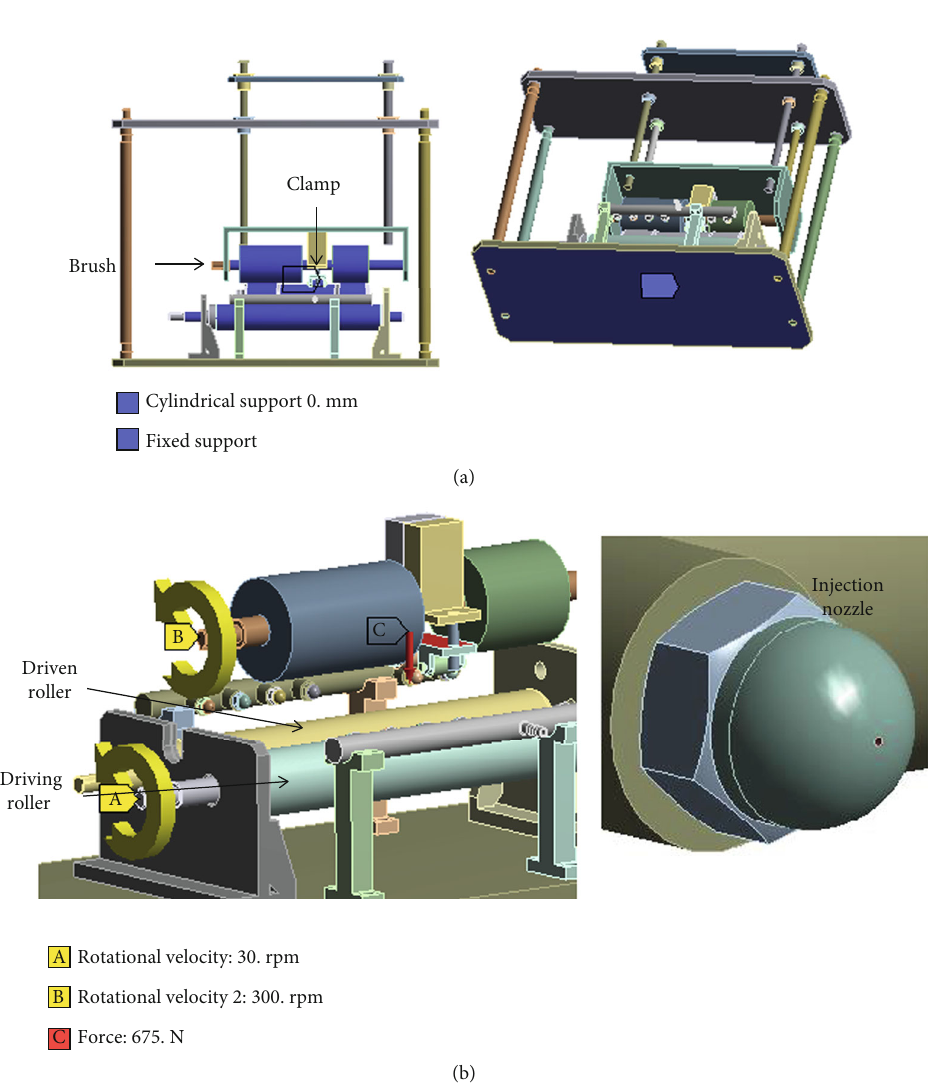
Figure 12: Boundary and load conditions: (a) boundary conditions and (b) load